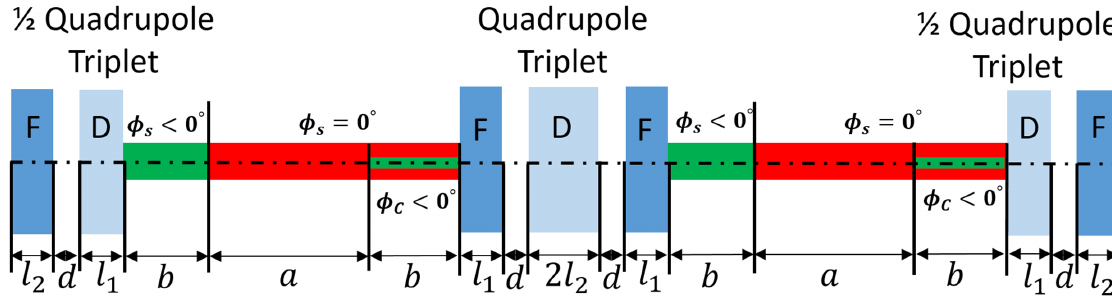
FIG. 15. Scheme of a KONUS period in a DFD-O-FDF-O- focusing lattice. The red bar marks the extension of the zero degree